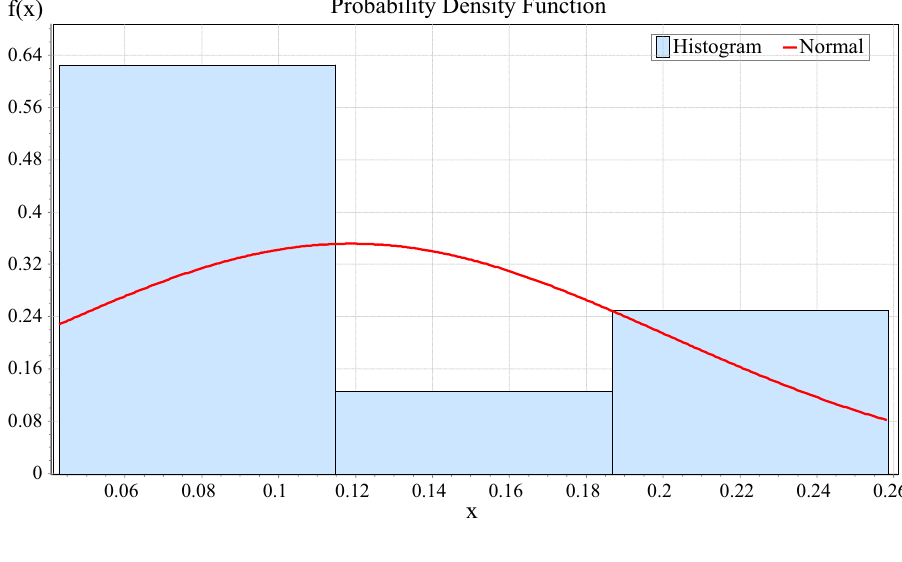
Fig. 1 Histogram of the